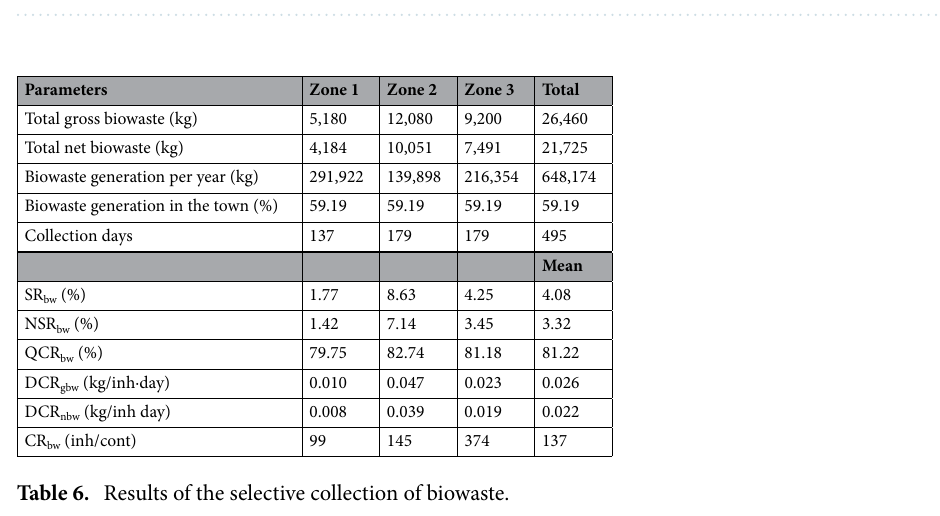
Table 5. Composition of the waste in the mixed waste container.